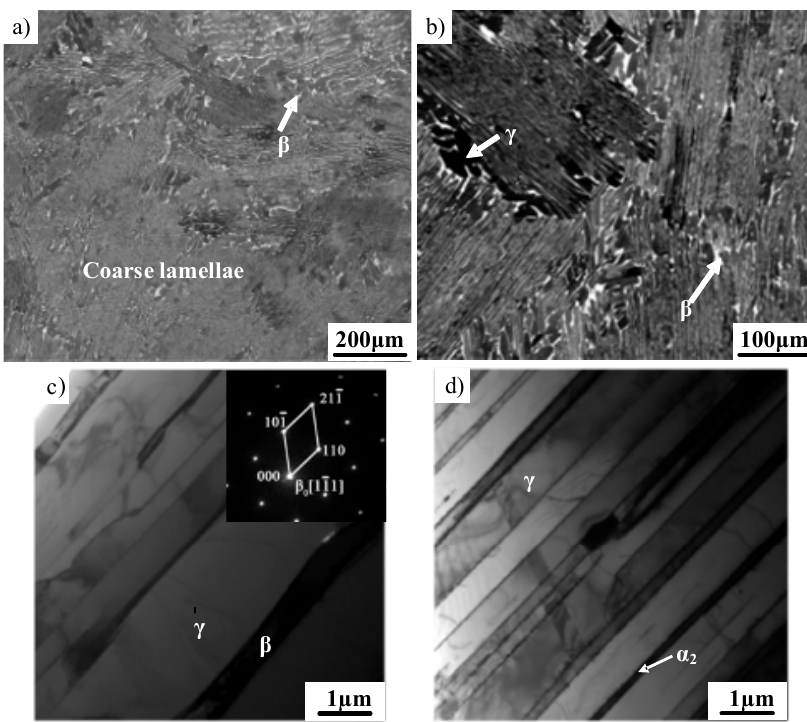
Figure 1. As-cast microstructure of the Ti–43Al–2Cr–2Mn–0.2Y ingot. ( a , b ) Coarse lamellar colonies (SEM), ( c ) β phase (TEM), ( d ) γ / α 2 lamellae (TEM).